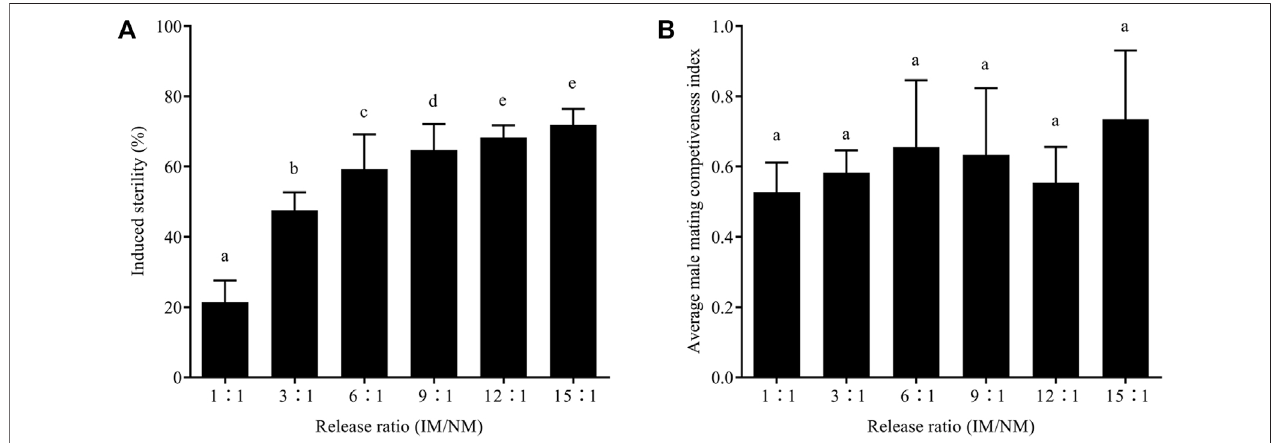
FIGURE5| Effectsofirradiationoninducedsterility (A) andmalematingcompetitivenessindex (B) of E.elutella atdifferentreleasingratios.Errorbarsrepresentthe SD from the mean of three independent replicates. Different letters indicate signi fi cant differences among treatments (ANOVA and Tukey ’ s HSD test, p < 0.05)